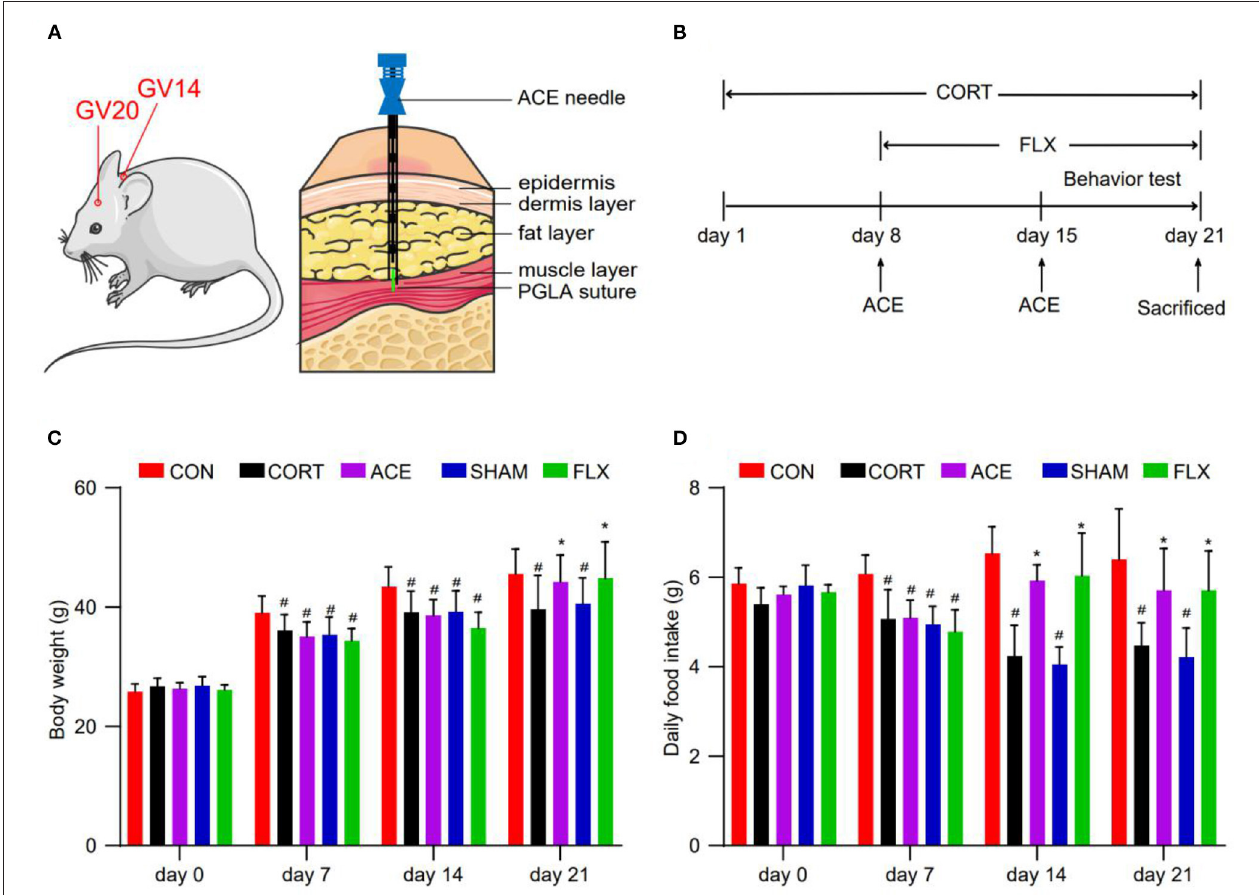
FIGURE 1 | Effect of ACE on the body weight and daily food intake of mice. (A) ACE treatment demonstrating the position of acupoints (GV20 and GV14) in mice. (B) Experimental schedule of this study. (C) The body weight of mice in all subgroups were weighted every week during the experimental period at 8a.m. ( n = 16 per group). (D) The daily food intake of mice in all subgroups were weighted every week during the experimental period at 8a.m ( n = 16 per group). Experimental values were expressed as means ± SD. # P < 0.05 compared with the CON group. * P < 0.05 compared with the CORT